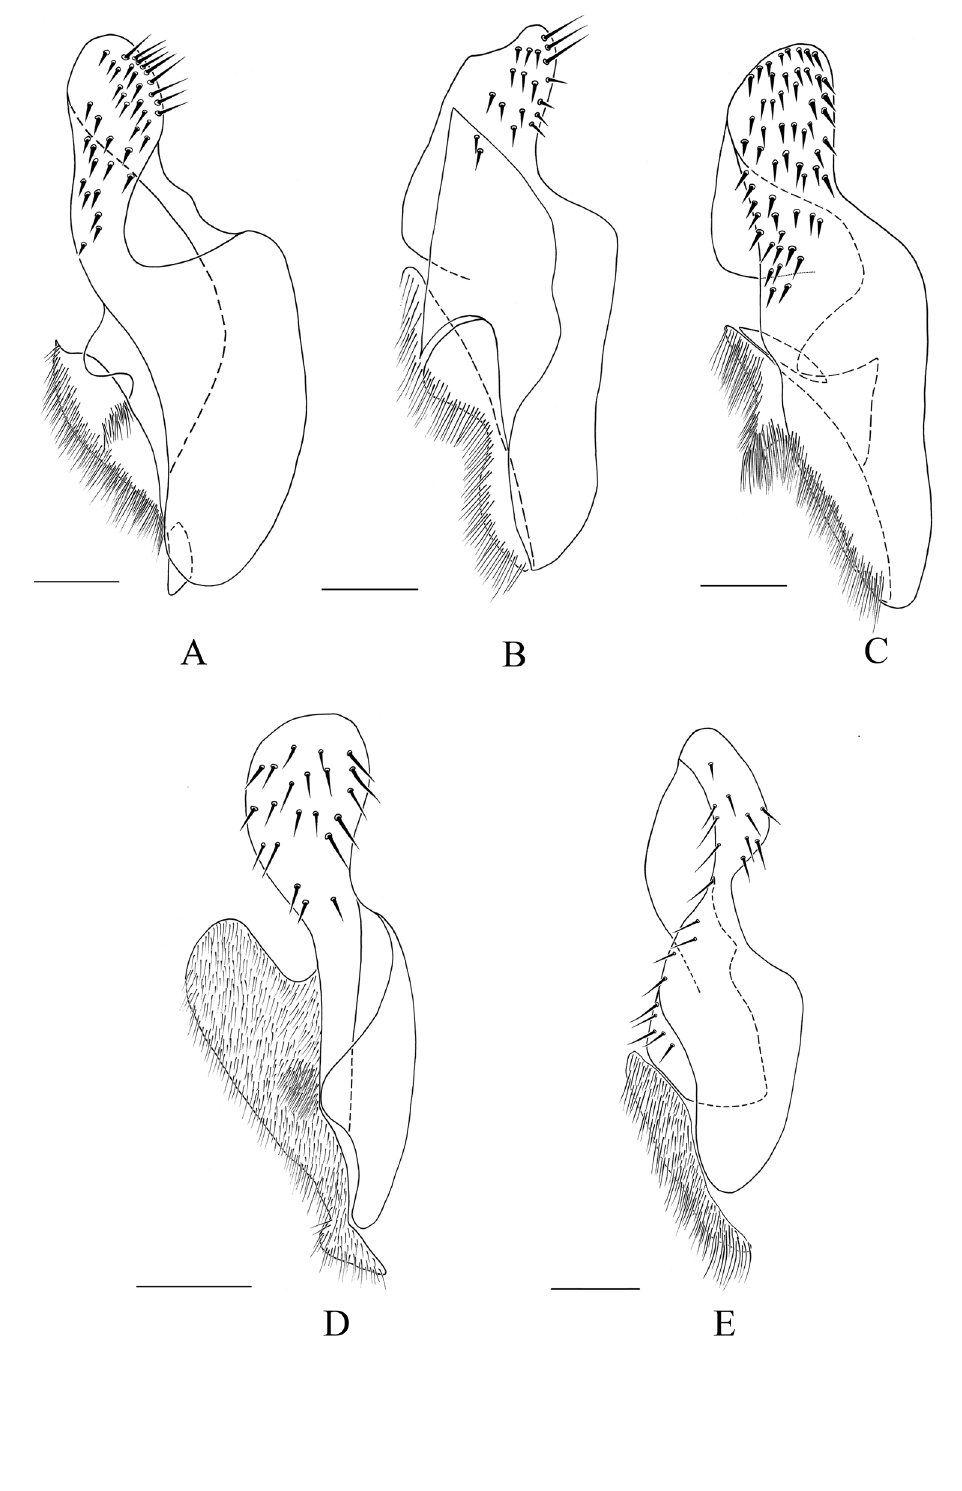
Fig. 21. Right surstylus, dorsal view. A . Eumerus hissaricus Stackelberg, 1949, Ghoochan, Iran (HMIM). B . E. kazanovzkyae Paramonov, 1927, Paveh, Iran (HMIM). C . E. pilosipedes Gilasian & van Steenis sp. nov., holotype (HMIM). D . E. vallicolus Gilasian & van Steenis sp. nov., holotype (HMIM). E . Eumerus sp., Khash, Iran (HMIM). Scale bars = 0.1